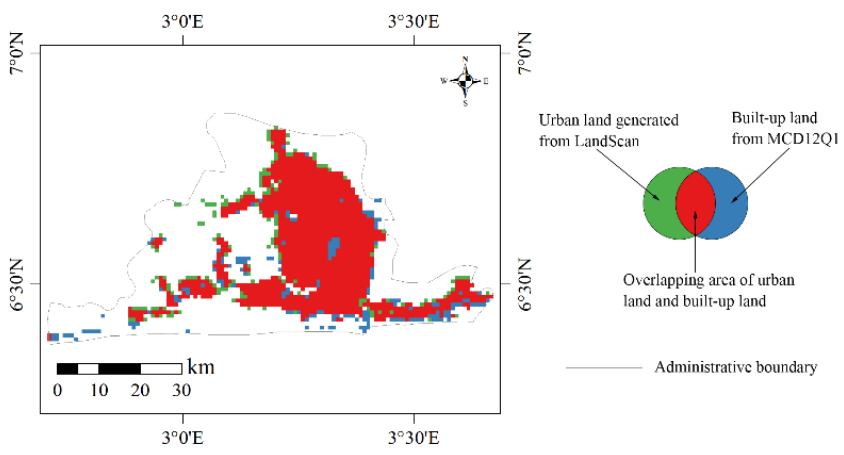
Figure 4. Overlapping diagram of urban land generated from LandScan and built-up land from MCD12Q1: taking Lagos in 2019 as an example.